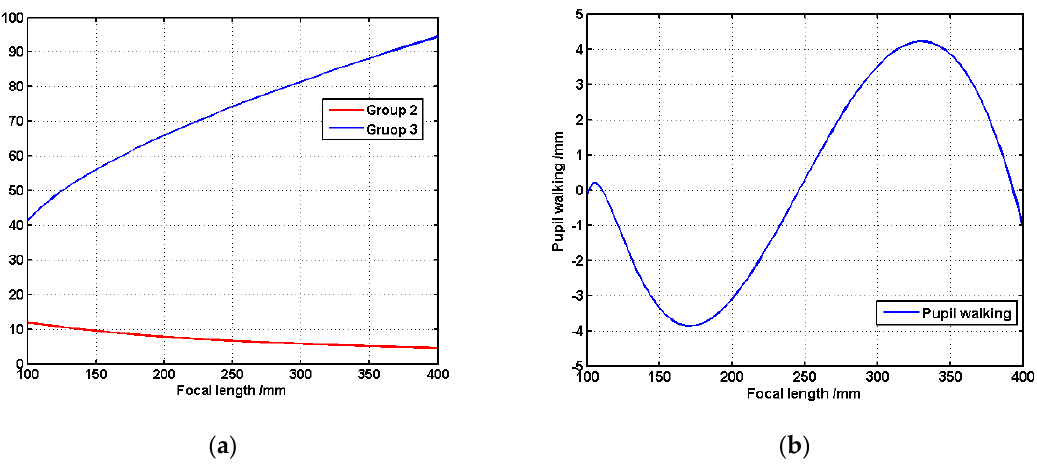
Figure 5. Cam curve and pupil walking of the proposed design. ( a ) Cam curve of the 4× zoom optical system, and ( b ) Pupil walking of the 4× zoom lens.